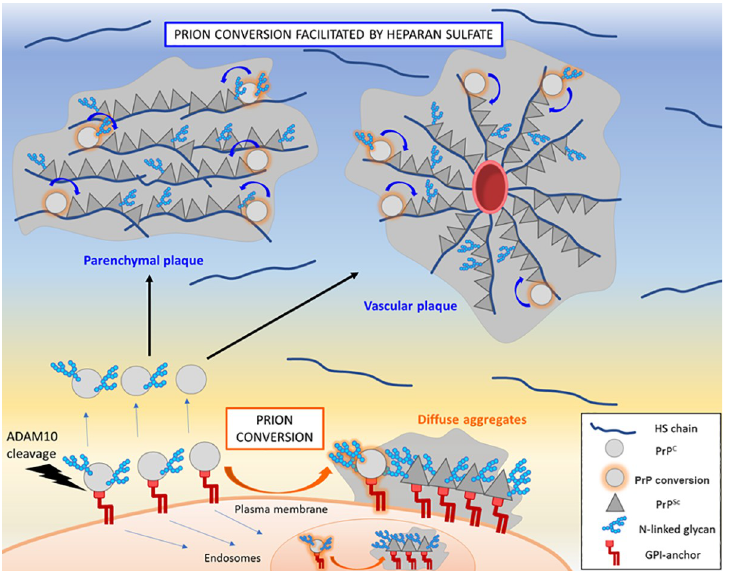
Fig 1. Model of how PrP PTMs may impact HS-mediated prion conversion. Prion conversion of GPI-anchored prions occurs at the cellular membrane or intracellularly within the endolysosomal pathway. GPI-anchored prions bind inefficiently to HS and form diffuse and small plaque-like aggregates containing a mixture of di-, mono-, and unglycosylated PrP Sc . Prion conversion of GPI-anchorless prions may occur extracellularly, as approximately 10% to 15% of the cellular prion protein (PrP C ) is constitutively cleaved from the plasma membrane by ADAM10 [40]. Shed, ADAM10-cleaved PrP C traffics through the interstitial fluid by bulk flow and binds HS chains in the extracellular matrix and vascular basement membrane. PrP Sc also binds HS; thus, HS potentially facilitates PrP C and PrP Sc interaction and scaffolds assembly (curved arrows). Poorly glycosylated PrP (mono- and unglycosylated) binds to HS and is enriched in prion fibrils. ADAM10, A-disintegrin-and-metalloproteinase domain-containing protein 10; GPI, glycosylphosphatidylinositol; HS, heparan sulfate; PrP, prion protein; PrP C , cellular prion protein; PrP Sc , misfolded and aggregated prion protein.